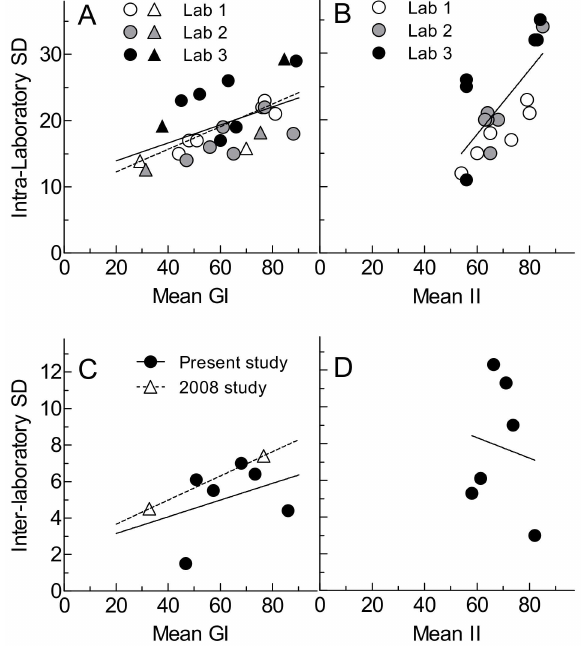
Figure2. RelationshipsbetweenmeanandSDofGIandIIwithin-andbetween-laboratories. Top panels: relationship between mean and SD of GI ( A ) and II ( B ) values of foods. Bottom panels: relationship between mean and inter-laboratory SD of GI ( C ) and II ( D ) values of foods. Circles are data from Table 3; triangles are data for the same three laboratories taken from a previous inter-laboratory study [10]. Lines are regression lines: solid lines are for data from the present study (panel A, r = 0.480, n = 18, p = 0.044; Panel B, r = 0.719, n = 18, p = 0.0008; panel C, r = 0.340, n = 6, p = 0.51; panel D, r = − 0.270, p = 0.80). Dashed lines are for data from the previous study (panel A, r = 0.701, n = 6, p = 0.12; panel C, the line connects two